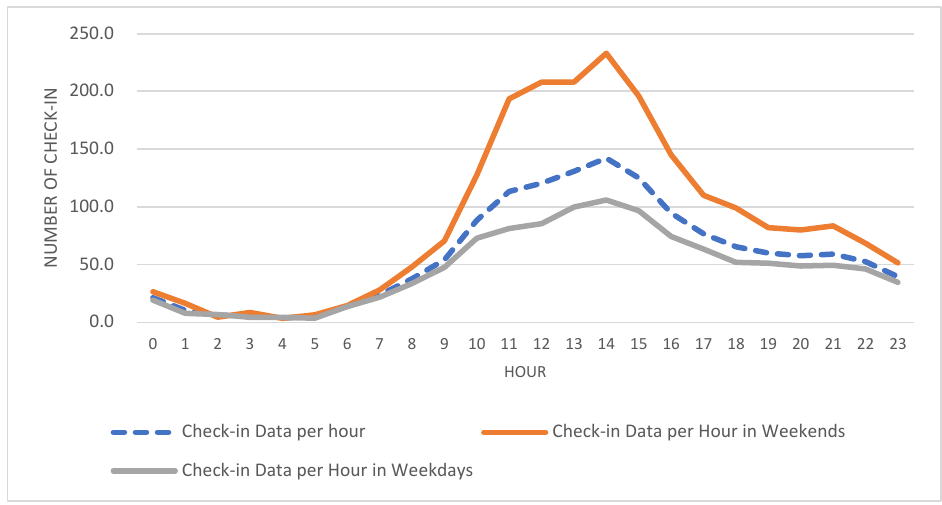
Figure 6. The weekday and weekend distribution of Fengjing Ancient Town Sina Weibo check-in data during the 2012 to 2020 period (source: authors).